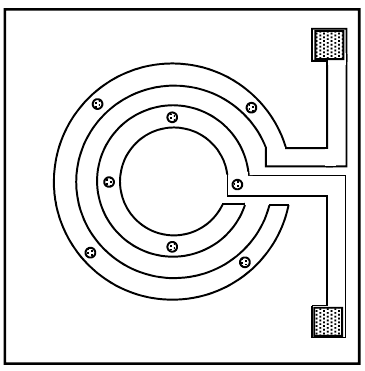
Figure 5. Schematic representation of the 1-channel chemosensitive resistor device used in the initial viability test.